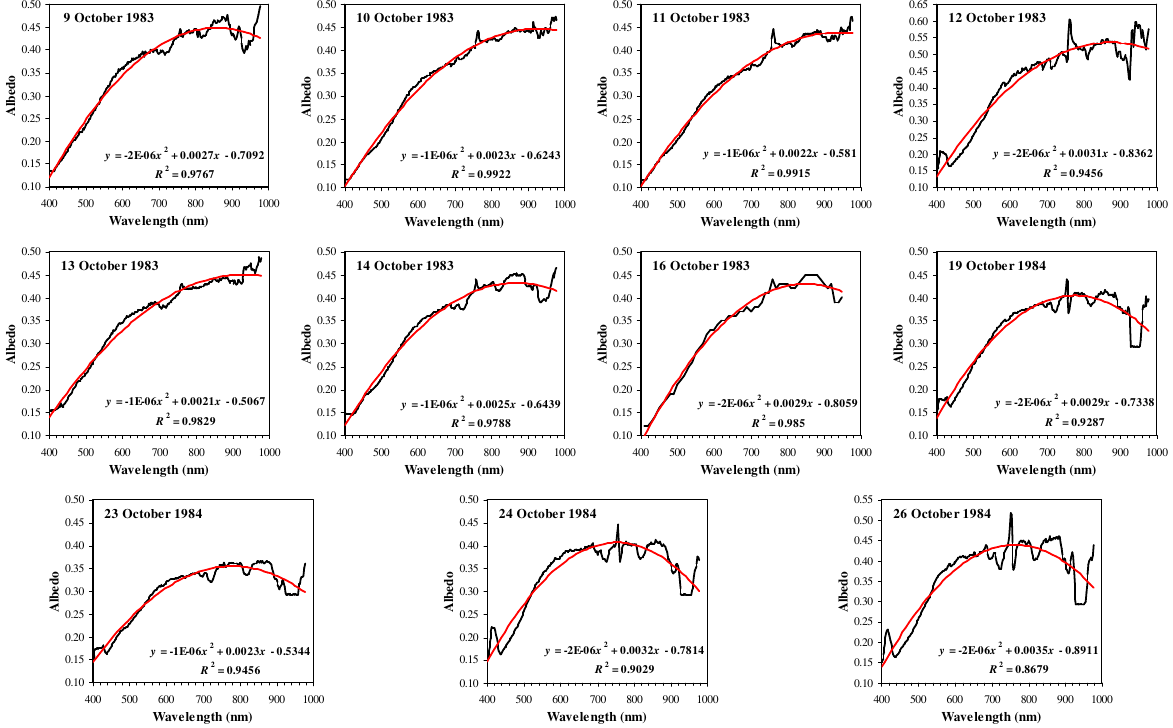
Figure 6. Spectral dependence of albedo for the sand surface (above the Kara-Kum Desert) in the visible and infrared spectra, as deduced from airborne observations conducted on the following 11 days: 9 October 1983 (401–978nm), 10 October 1983 (401–978nm), 11 October 1983 (401–978nm), 12 October 1983 (401–978nm), 13 October 1983 (401–978nm), 14 October 1983 (401–978nm), 16 October 1983